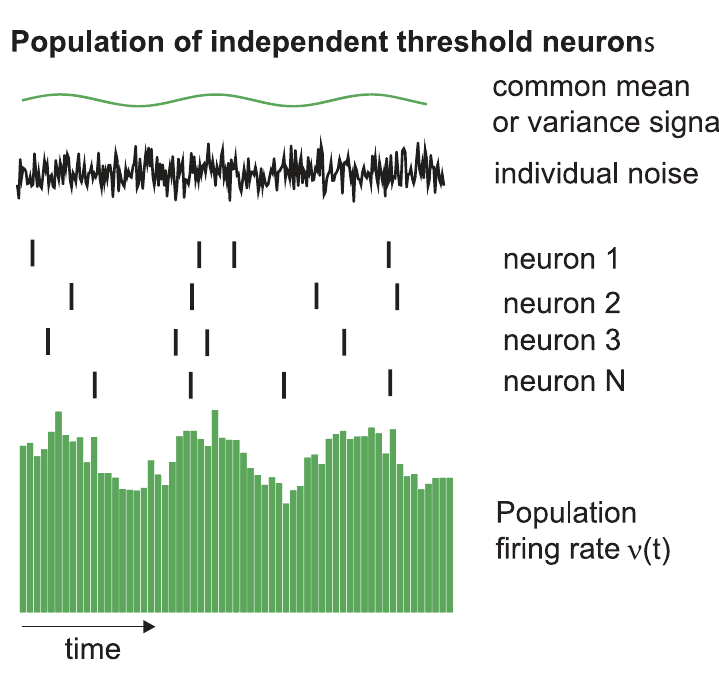
Figure 3. Spike generation and signal representation in the single spiking threshold neuron. (A) Spike generation from a temporally correlated Gaussian voltage trace in a single threshold neuron. (B) Encoding of common signals by the population firing rate n ( t ) of independent threshold neurons. Note, that n ( t ) can be either linearly related to the stimulus (linear regime for weak signals, Eq. 11, 12) or be described by a non- linear response function (e.g. see Eq. 20).